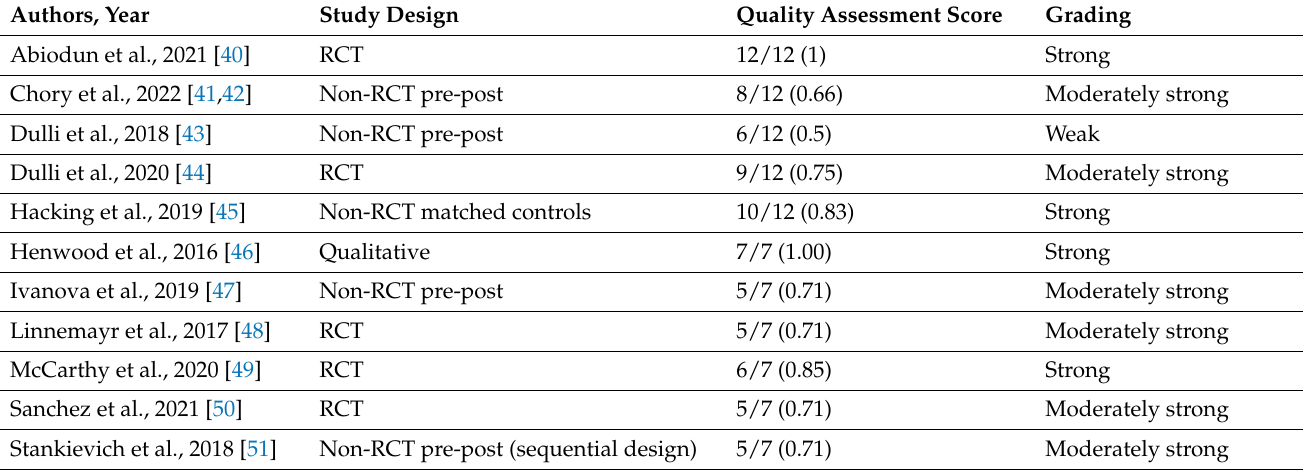
Table 3. Quality assessment.